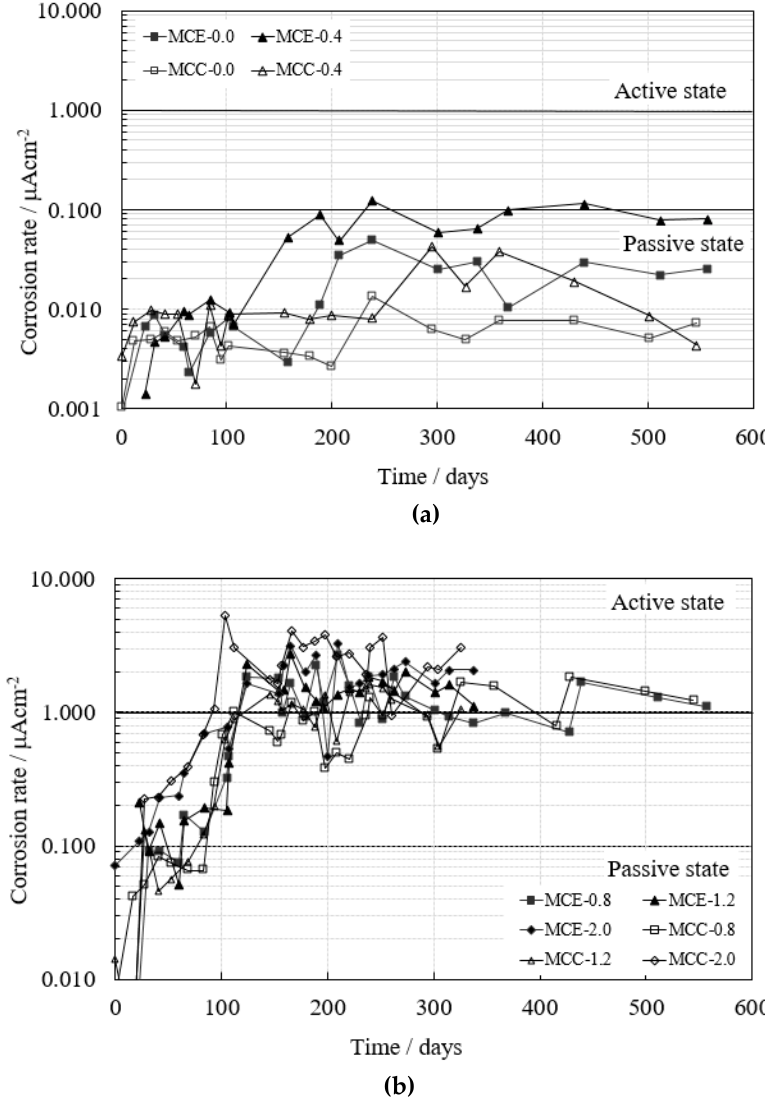
Figure 4. Evolution of i corr over time in test specimens without chlorides and with 0.4% chloride ions by weight of cement ( a ) and in test specimens with chloride ion percentages of 0.8%, 1.2% and 2% ( b ).